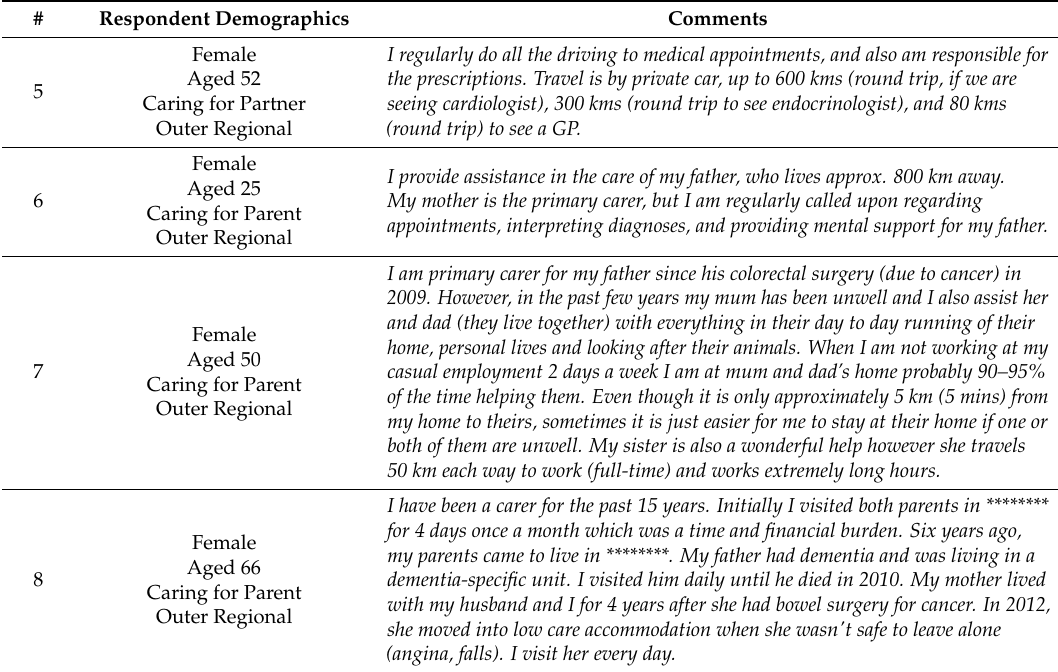
Table 4. Respondent commentary on travelling distance and care